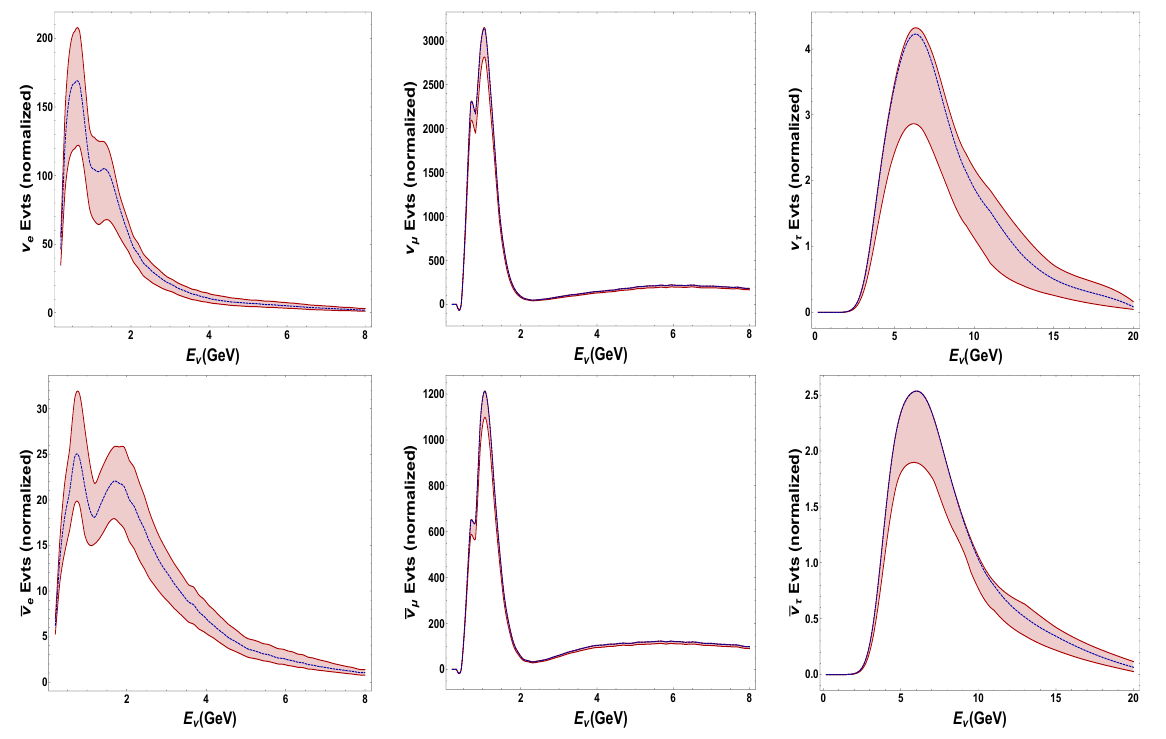
Figure 3. Same as Figure 1 but for the 3 + 1 neutrino mass model.